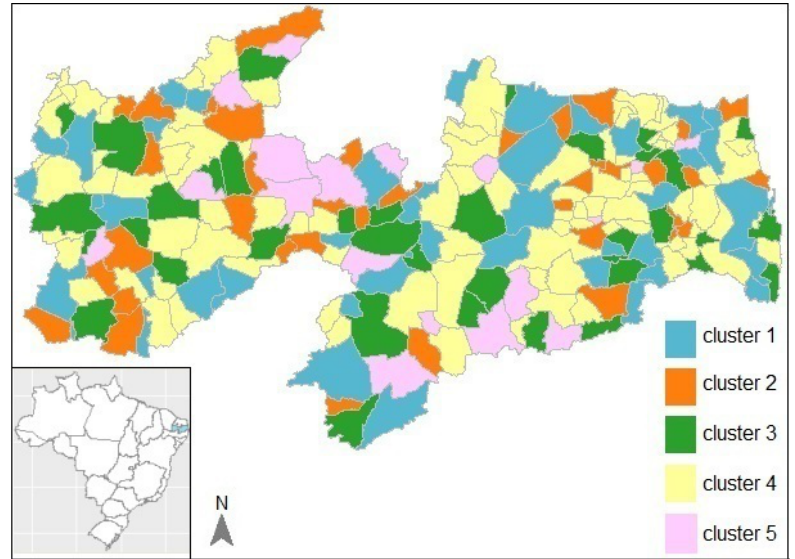
Figure 2. Map of the partition with 5 clusters only based on the socio-epidemiological variables (that is using D 0